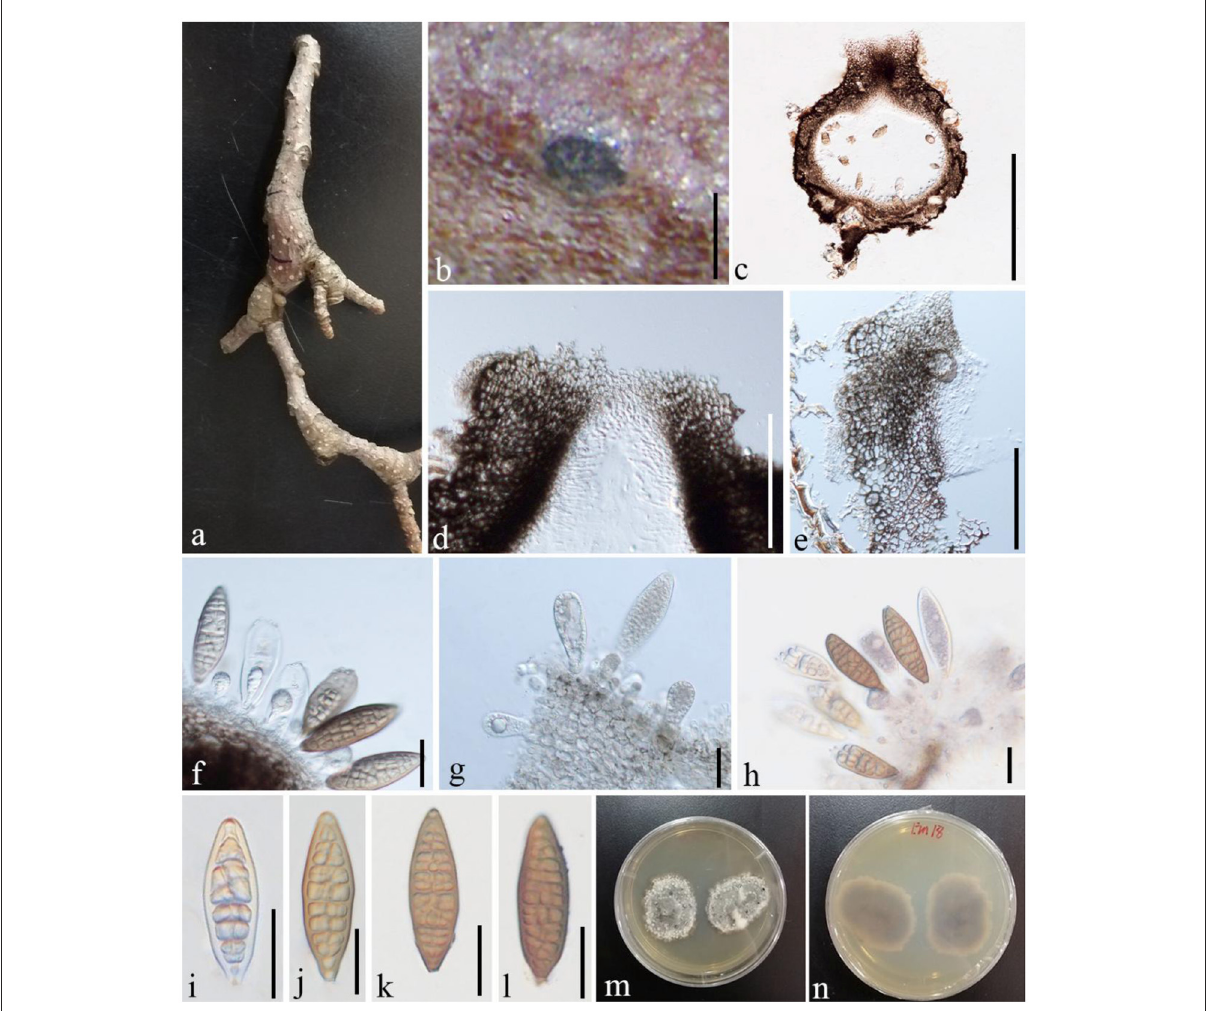
FIGURE11 S. formosa (GMB1379, a new host record on M. grandiflora from China). (a) M. grandiflora branch. (b) Appearance of ascomata on host. (c) Vertical sections of conidioma. (d) Osti-ole opening. (e) Peridium. (f–h) Conidia and conidiogenous cells. (i–l) Conidia. (m,n) Seven-day-old colonies incubated at 28 ◦ C on PDA. Scale bars: (b) = 300, (c) = 430, (d ) = 100, (e) = 55, (f) = 25, (g) = 20, (h) = 25, and (i–l) = 20 µ m.